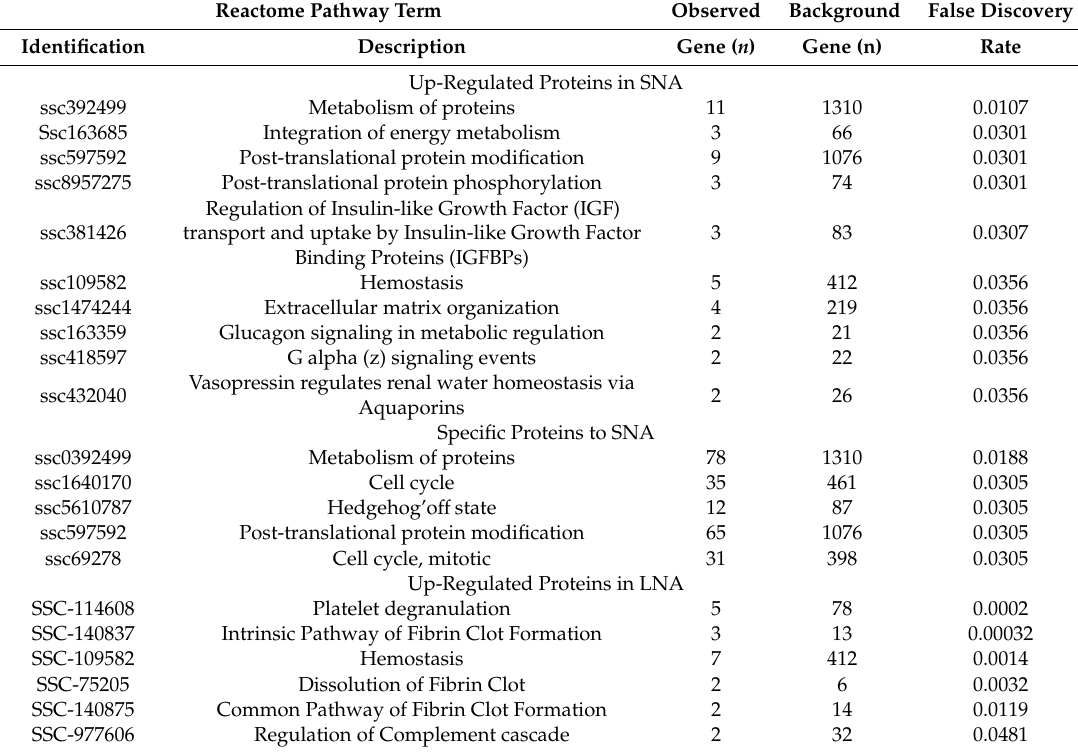
Table 2. Reactome pathways in protein datasets. No significant pathways were found for protein specific to